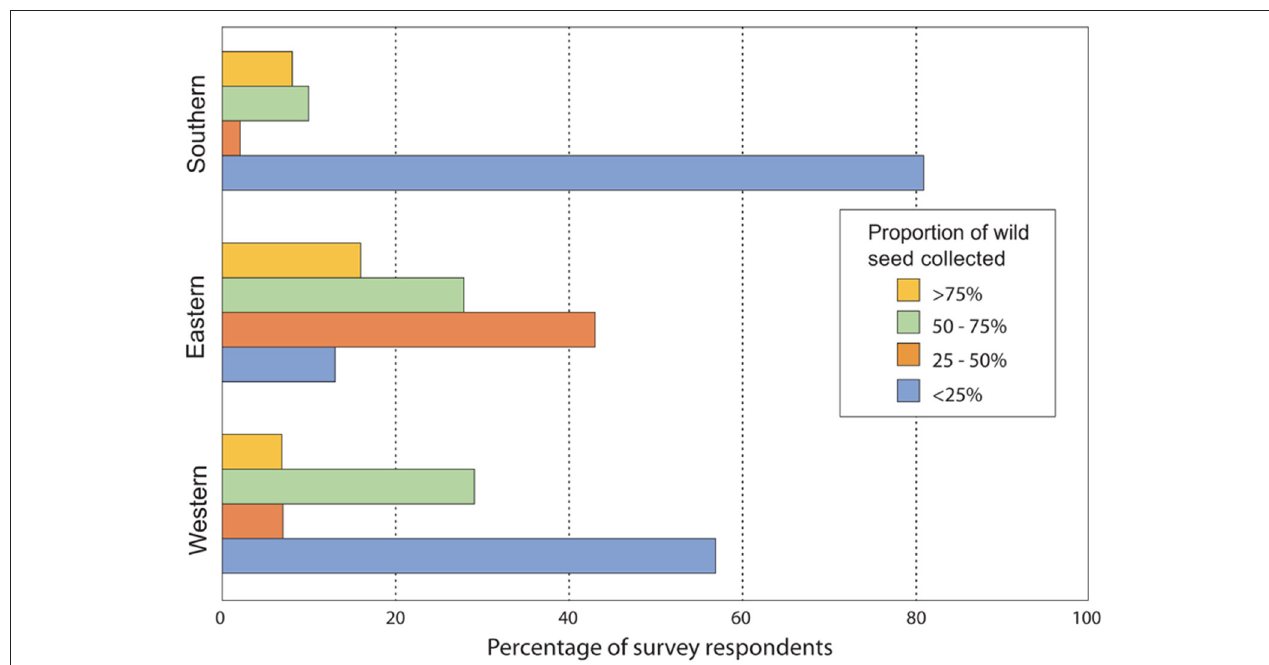
FIGURE 4 | Percentage of seed that is collected from the wild (as opposed to from orchards or SPAs) as used by tree nurseries in three regions of the US. We excluded nurseries that reported at least 50% of their seeds coming from unknown sources. Sample size was 17, 33, and 50 for southern, eastern, and western regions,